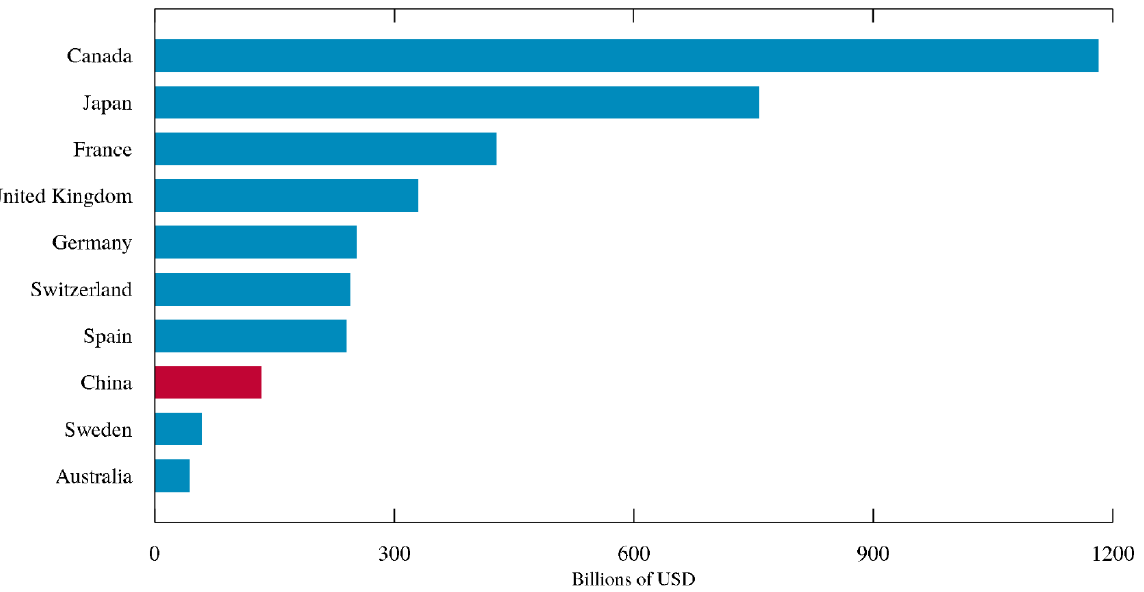
Figure 4. U.S. branch assets of foreign banking organizations as of End-2020. Source: Responses to FFIEC 002 reporting form.